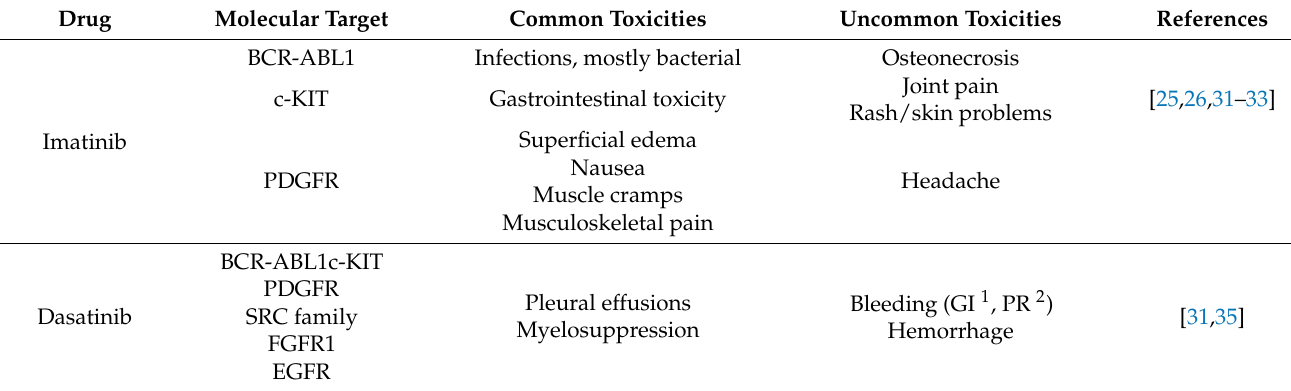
Table 1. Comparison of most common toxicities of specific kinase inhibitors associated with targeted therapy in patients with